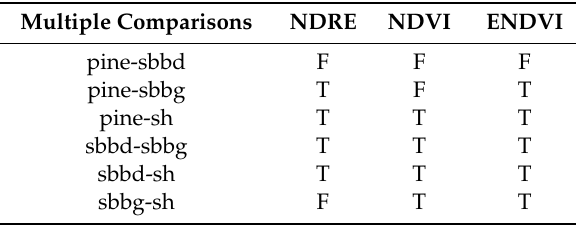
Table A1. Investigation of the disturbance class separability using extracted spectral feature statistics from BUFFER crows within las02. The table shows a post-hoc multiple comparison test after Kruskal–Wallis